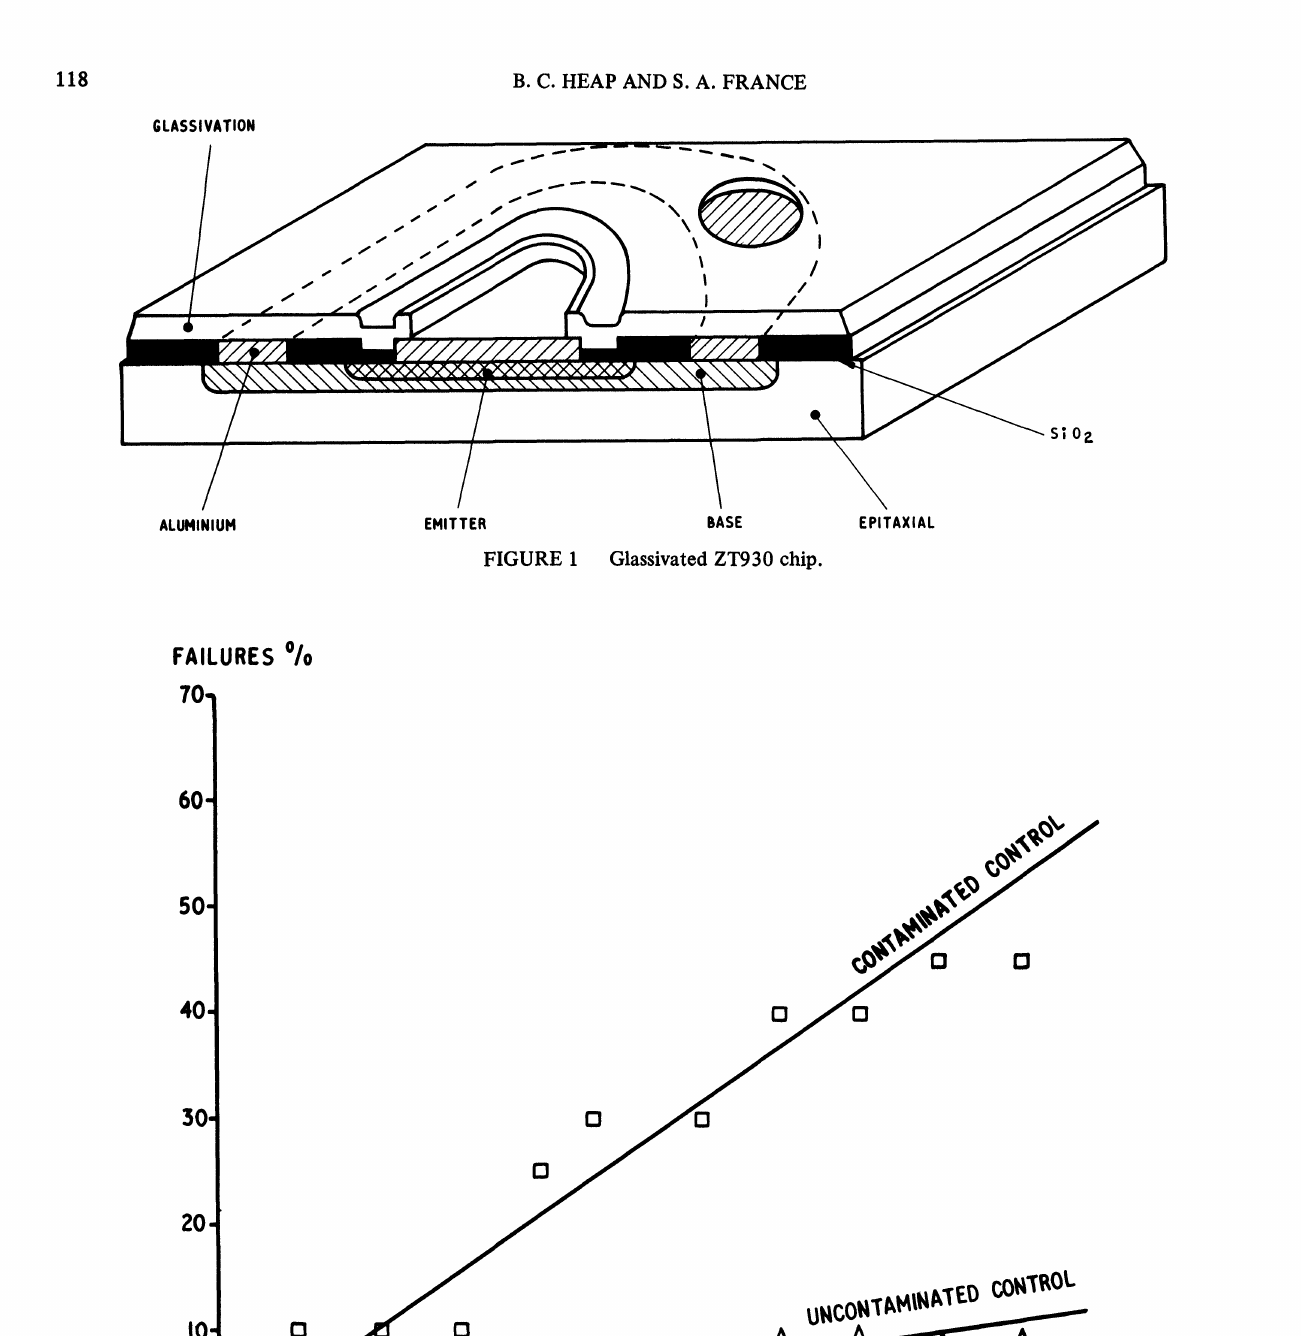
Graph of percent failures against test time for contaminated glassed transistors, contaminated control and uncontaminated control in ion getter